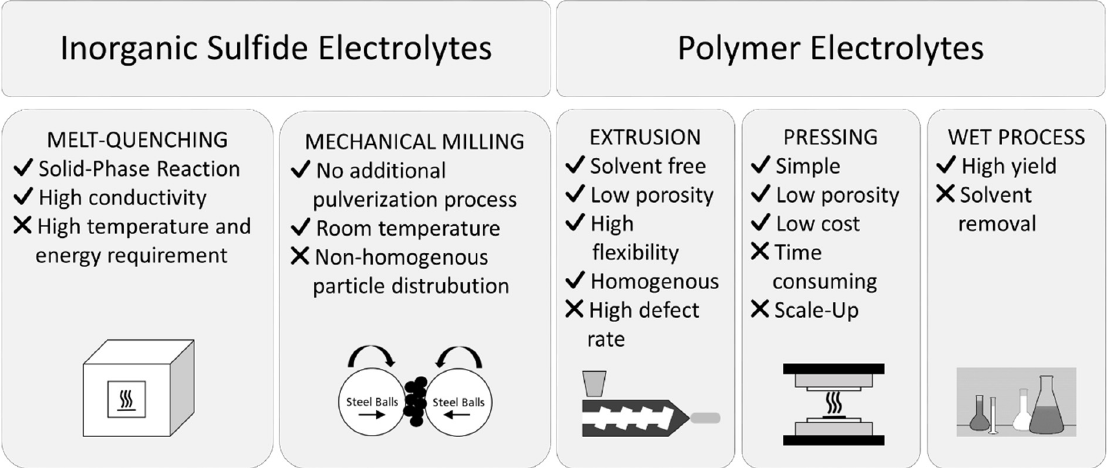
Figure 3. Most common preparation techniques of different type of SEs. Both inorganic solid electrolytes (InSEs) and SPEs can be introduced to SSB cell via cold- or hot- press techniques by pressing solid-state electrolyte powder directly to the cathodes. Nevertheless, there is a need for new approaches (e.g., use of binders) in order to increase cathode-solid electrolyte contact.